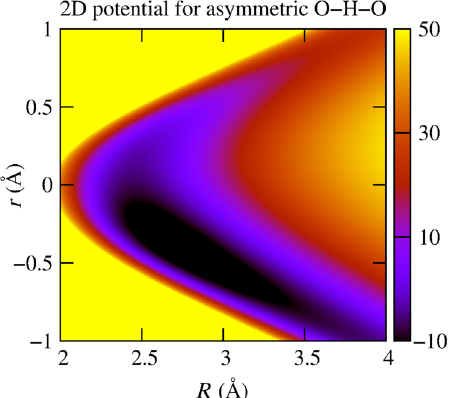
FIG. 1. Potential of the hydrogen bond model as a function of the O ─ O distance ( R ) and of the proton position ( r ) measured from the center of the O ─ O bond. The energy is measured in